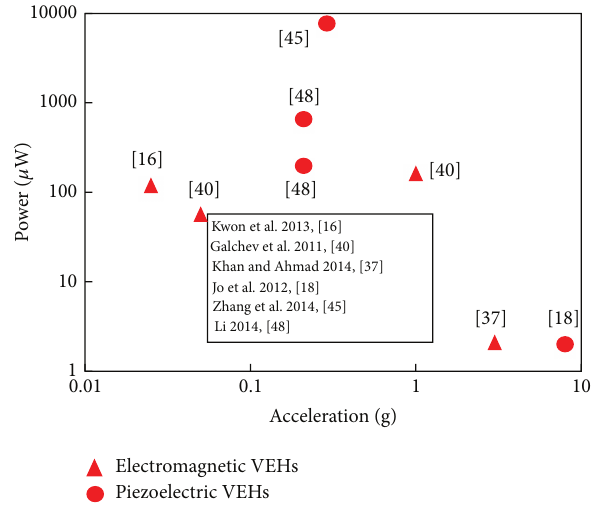
Figure 20: Power developed by the bridge energy harvesters as a function of